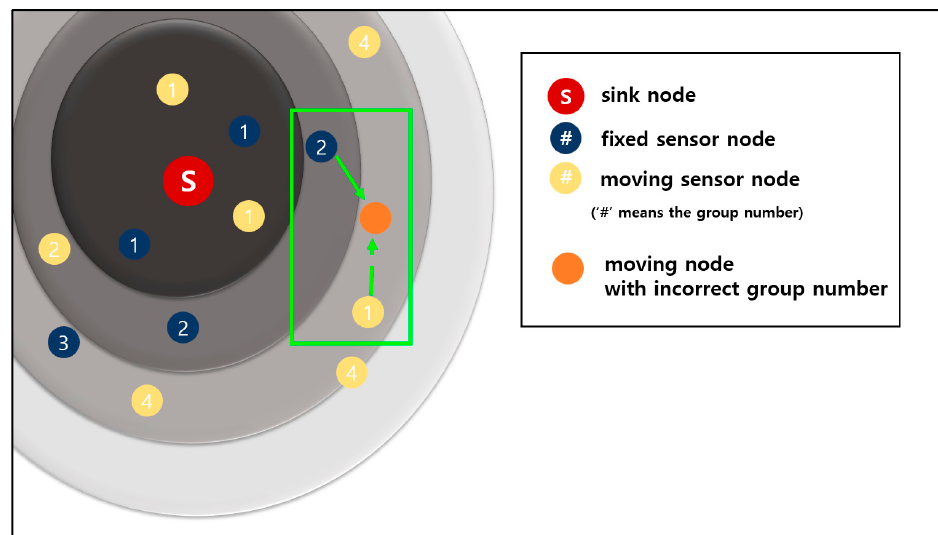
Figure 15. Incorrect group number setting scenario and its resolution.